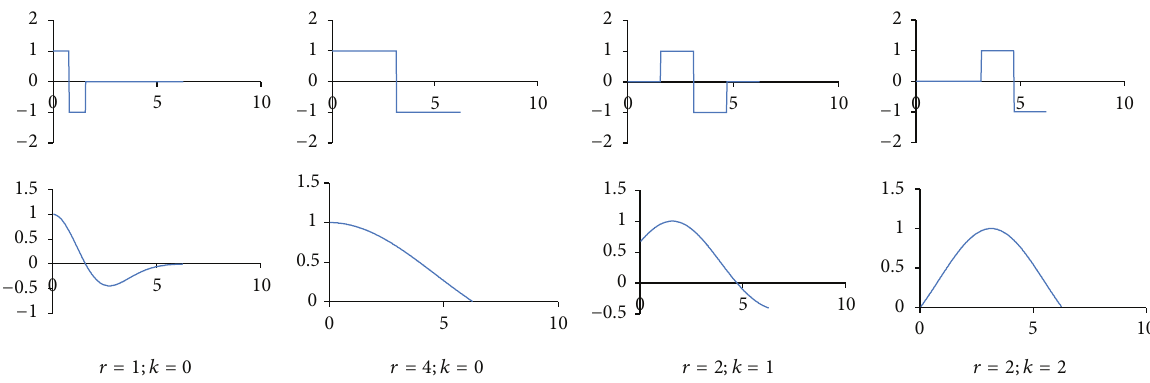
Figure 7: Part of the Haar and Mexican Hat wavelet building set derived within the interval [0,2𝜋] .